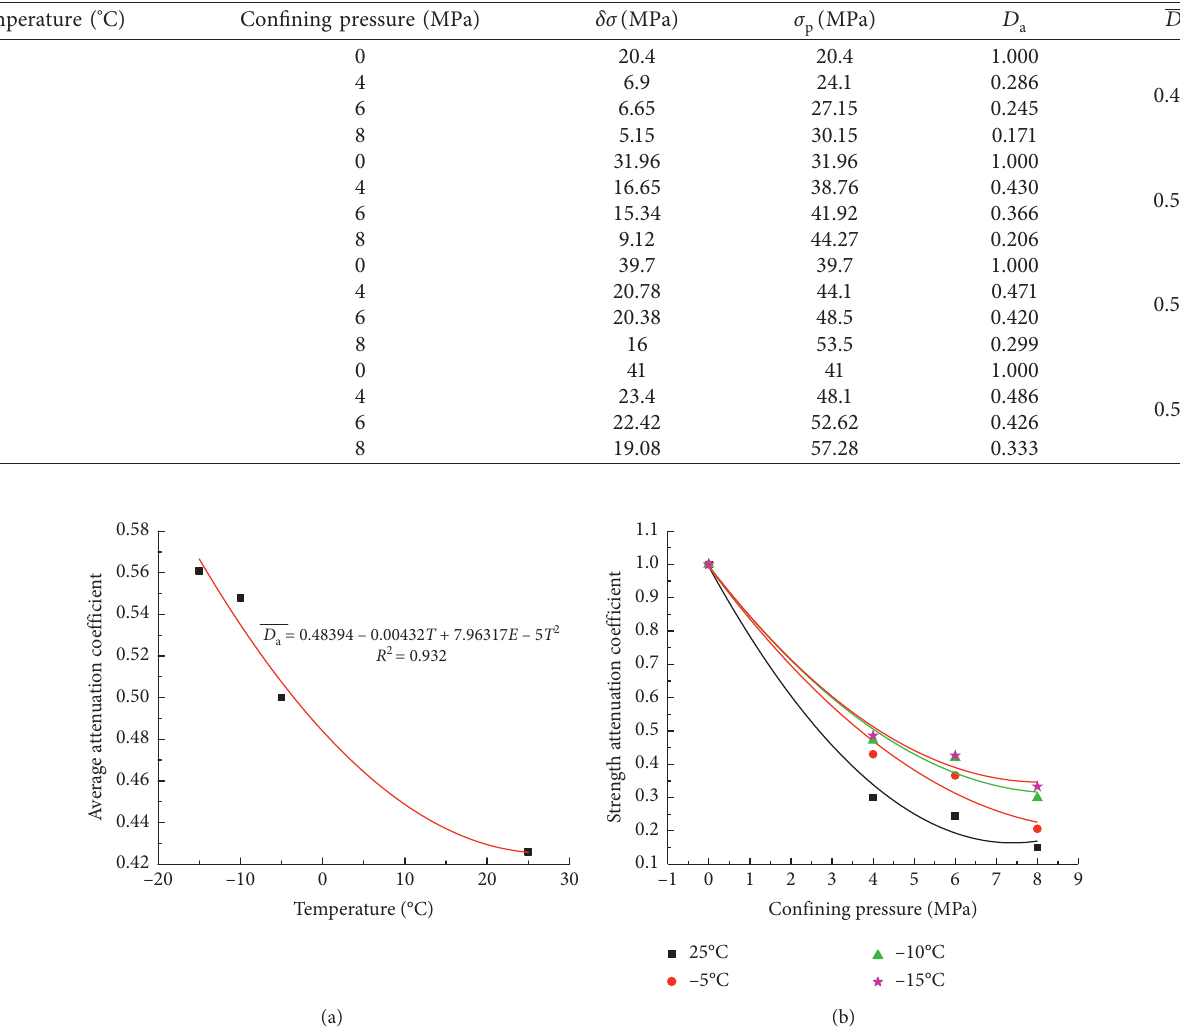
Table 3: Rock strength attenuation coefficients of Jurassic sandstones.